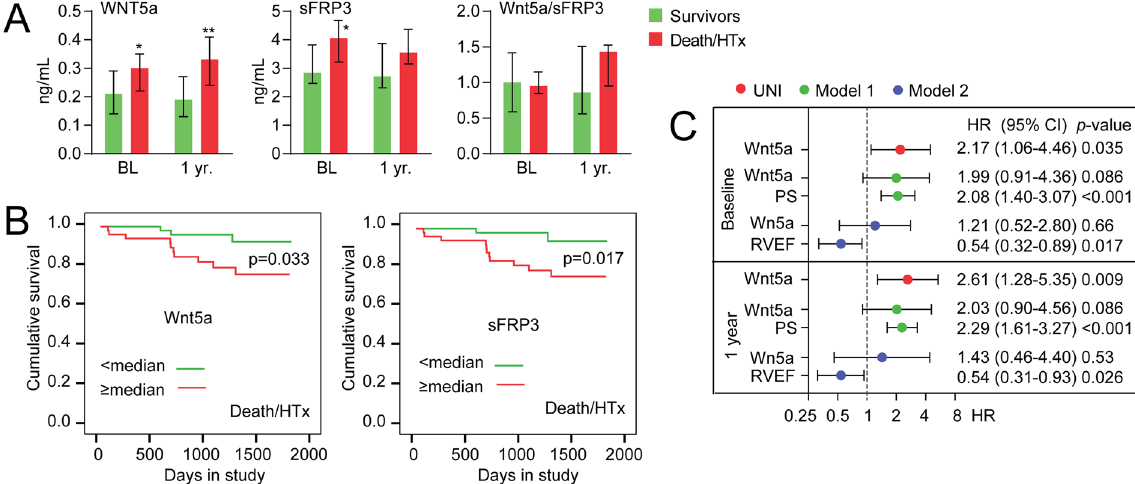
Figure 1. Wnt5a and sFRP3 associations with adverse outcome in patients with DCM. ( A ) Circulating Wnt5a, sFRP3 and their ratio (Wnt5a/sFRP3) in DCM patients with adverse outcome (death or HTx) vs survivors at baseline (BL) and 1 year follow-up. ( B ) Kaplan-Meier curves showing the cumulative incidence of mortality or HTx (n = 13) during the whole study period (median follow-up 3.3 years, 0.2–5.1), according to dichotomized levels of Wnt5a and sFRP3 at enrolment. ( C ) The relationship between Wnt5a and outcome shown as hazard ratios (HRs) and 95% confidence interval per standard deviation (SD) change with p-values for univariate (UNI), propensity score (PS) adjusted (age, gender, creatinine, NYHA and NT-proBNP) (model 1), and adjusted for RVEF (model 2) Cox hazards models. * p < 0.05, ** p < 0.01 vs . survivors. DCM, dilated cardiomyopathy, HTx, heart transplantation; NT-proBNP, N-terminal pro-brain natriuretic peptide; NYHA, New York Heart Association; RVEF, right ventricular ejection fraction; sFRP3, secreted frizzled-related protein 3.